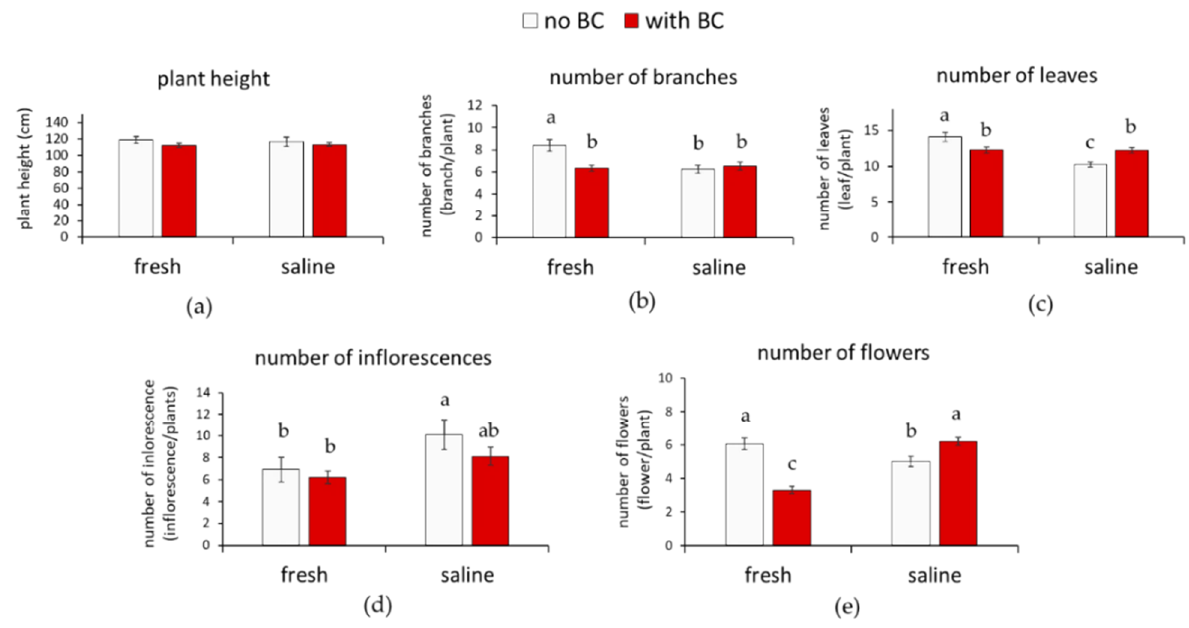
Figure 1. Effect of biochar addition on tomato plant response to salinity stress in terms of the following traits: ( a ) plant height, ( b ) number of branches, ( c ) number of leaves, ( d ) number of inflorescences, and ( e ) number of flowers. Values represented the means of five biological replications (three plants each) ± SE (n = 120, two seasons). Means with the same letters are not significantly different according to Duncan’s multiple range test (DMRT) ( p ≤ 0.05).